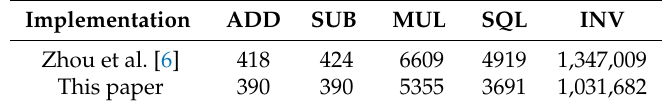
Table 2. Comparison of field arithmetic on ATmega128 processor in clock cycles.